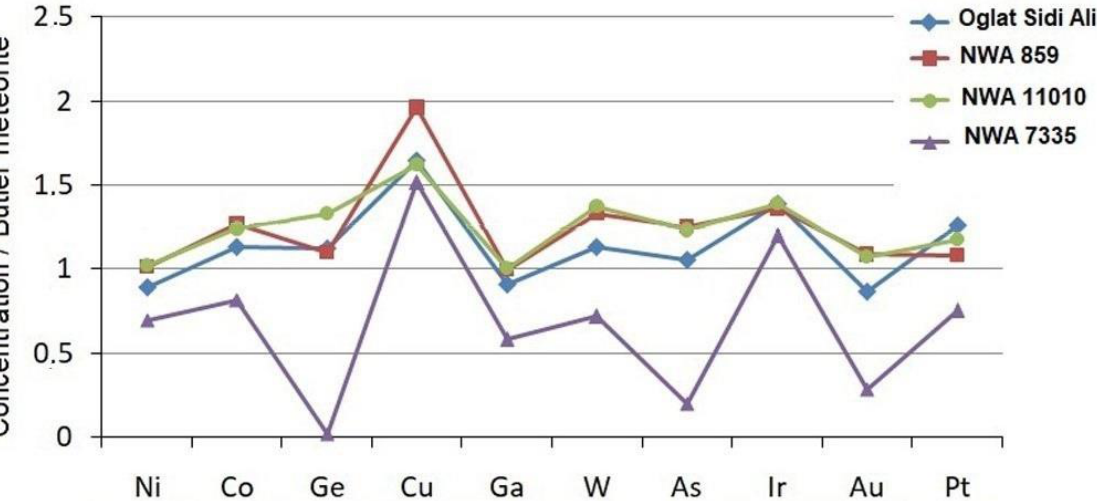
Figure 11. Ratios of the siderophile element contents of selected NWA ungrouped iron meteorites normalized to those of the Butler meteorite [21].